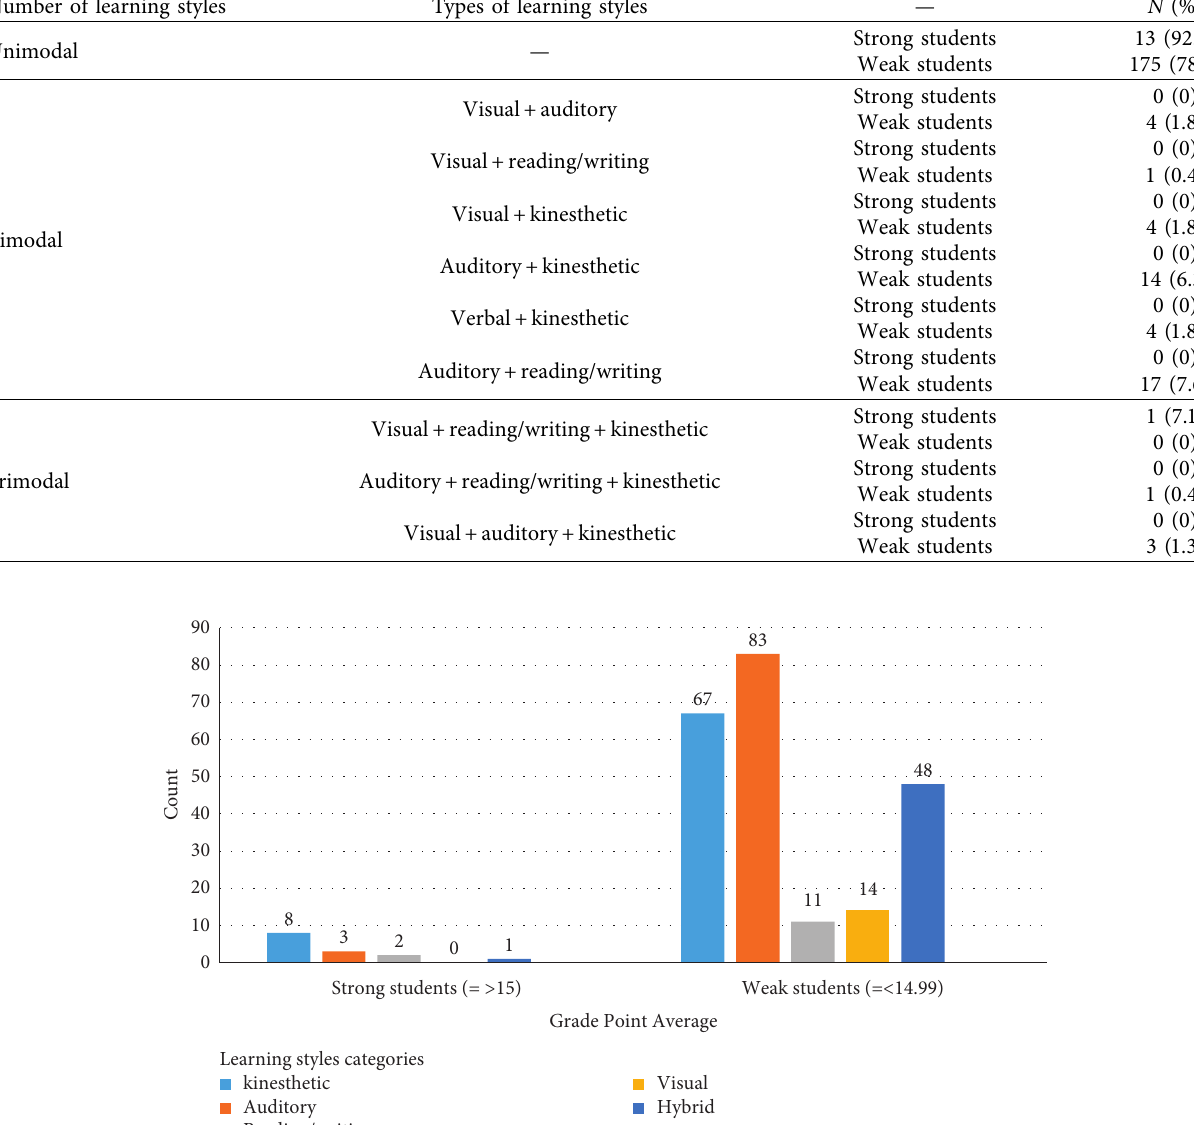
Table 3: Type and number of learning styles among students.